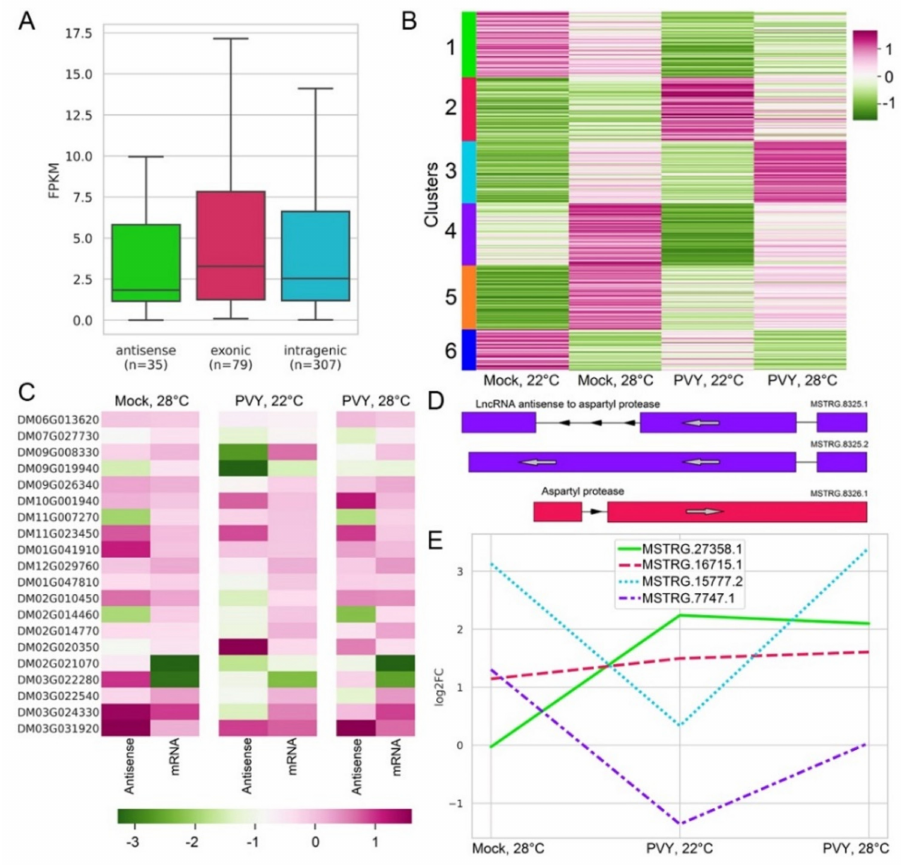
Figure 7. Differential expression of long non-coding RNAs. ( A ) Distributions of transcript expression of mRNAs and lncRNAs. ( B ) Heatmap and k-means clustering based on FPKM values of differentially expressed lncRNAs. ( C ) Heatmap comparing log 2 FC of lncRNAs antisense to mRNAs and corre- sponding mRNAs. ( D ) An example of StringTie annotation of antisense lncRNA and corresponding mRNA which were up-regulated under PVY infection. ( E ) Log 2 FC of chosen lncRNAs with miRNA target